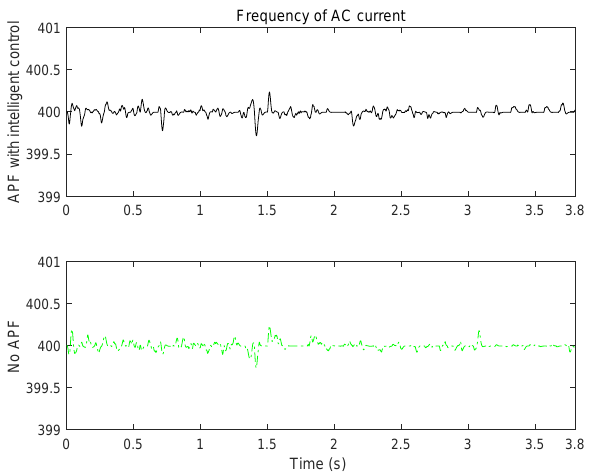
Figure 25. Frequency of AC